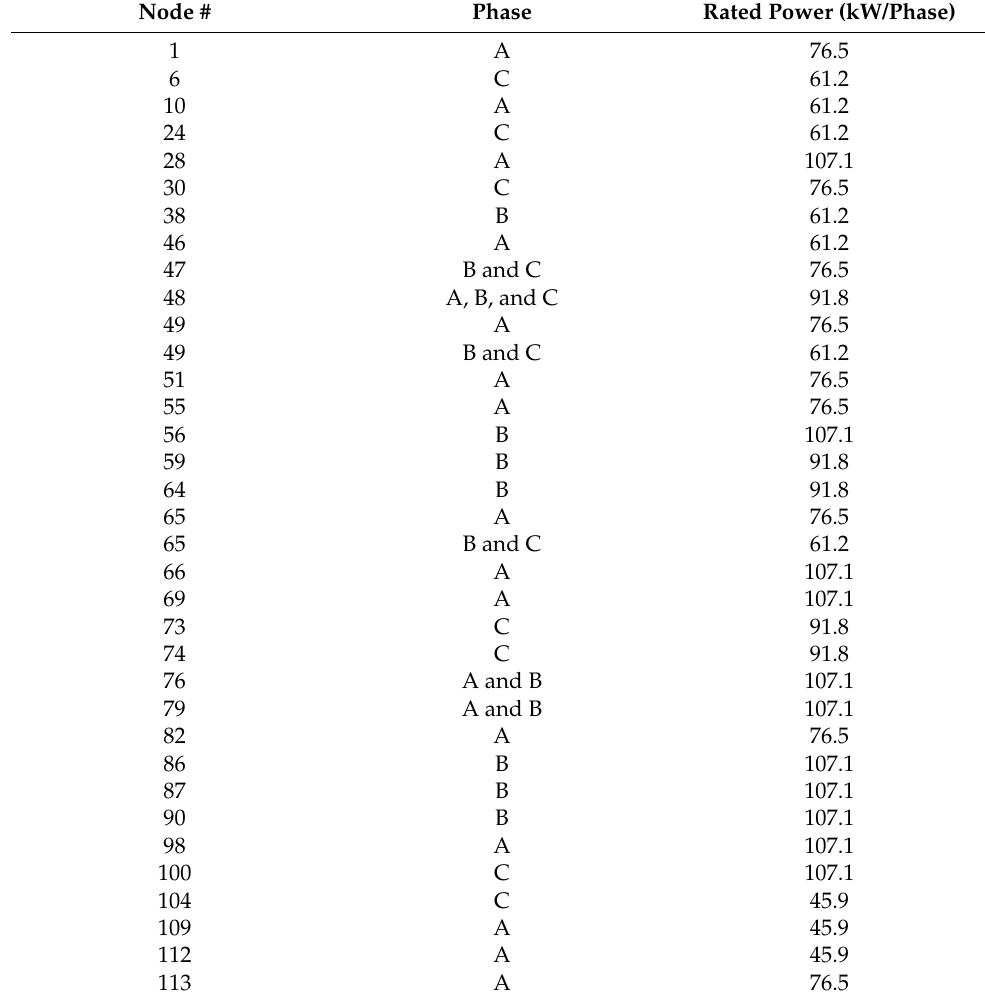
Table 2. Locations and power ratings of PV resources.